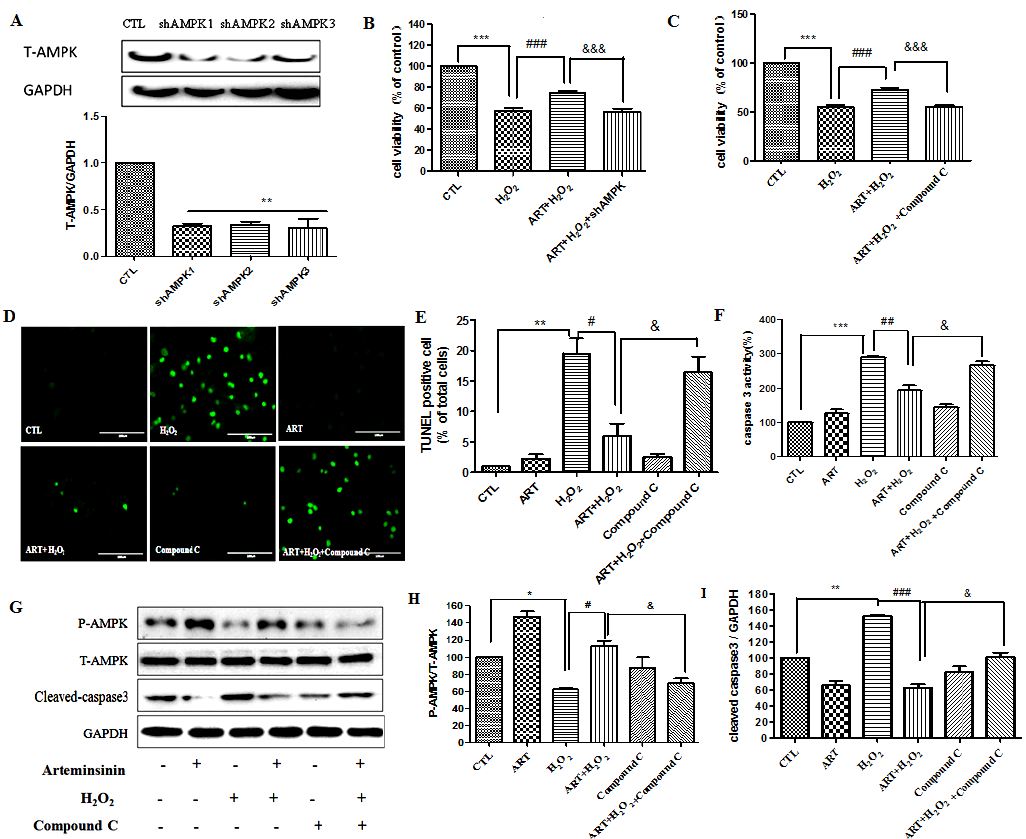
Figure 5. AMPK pathway mediated the protective effects of artemisinin in SH-SY5Y cells. ( A ). Cells were pretreated with shAMPKα 1–3 plasmid for 24 h, The knockout efficiency was determined by western blot. ( B ). Cells were pretreated with shAMPKα1 plasmid for 24 h before 12.5 μM artemisinin treatment for 2 h, and then incubated with or without 600 μM H 2 O 2 for a further 24 h. Cell viability was evaluated using the MTT assay. ( C ). Cells were pre-treated with 5 μM Compound C (AMPK inhibitor) for 30 min, and treated with 12.5 μM artemisinin for 2 h, then incubated with or without 600 μM H 2 O 2 for another 24 h, and the cell viability was determined by MTT assay. ( D – E ) TUNEL staining manifested that artemisinin attenuated H 2 O 2 -induced cell apoptosis significantly. The pictures have been taken at a magnification of 40× (100 μm). ( F ). The activity of caspase-3 was measured by caspase assay. ( G ). The expression of phosphorylated AMPK, total AMPK, cleaved caspase-3 and GAPDH were detected by western blot. ( H , I ). Quantitative analysis of ( G ). The data